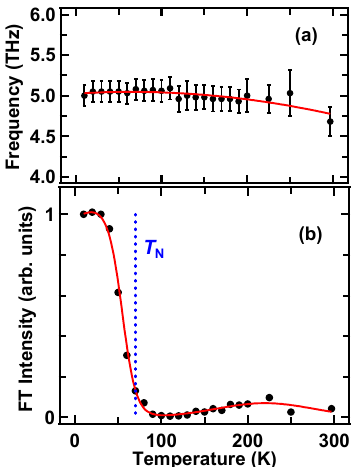
Figure 9. ( a ) Peak frequency of the FT spectrum in Figure 8b as a function of temperature, where the bar indicates FWHM of the FT band. ( b ) Integrated intensity of the FT band as a function of temperature, where the vertical dotted line indicates the Néel temperature. The solid curves in ( a ) and ( b ) are guides to the eye.